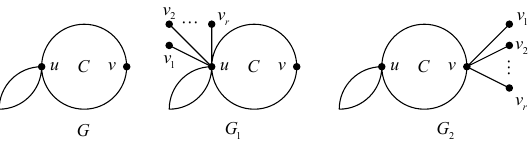
Figure 4. The graphs G , G 1 and G 3 in Transformation